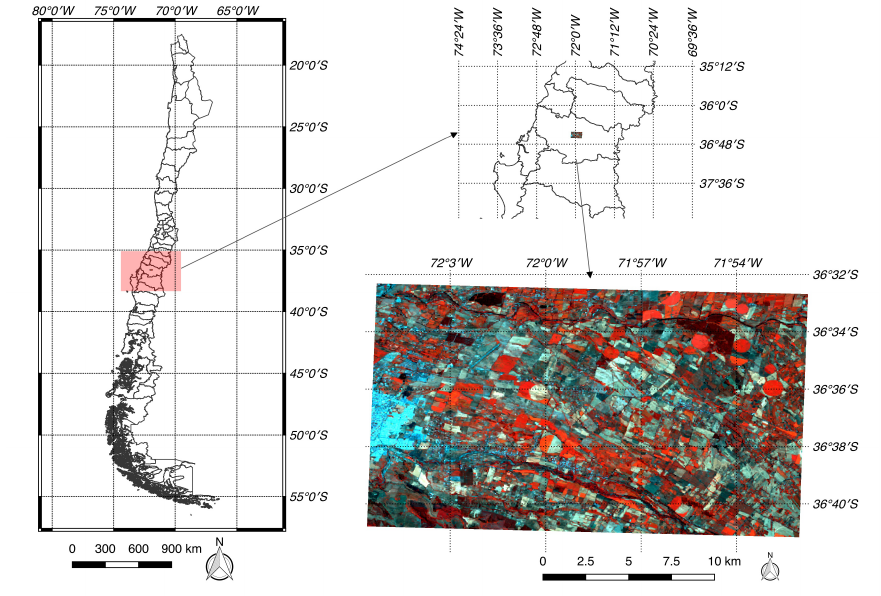
Figure 1. A location map and a false color composite (NIR, Green, and Blue bands) from Operational Land Imager (OLI) of the study site, located in the region of Biobío (Chile) and acquired on 16 February